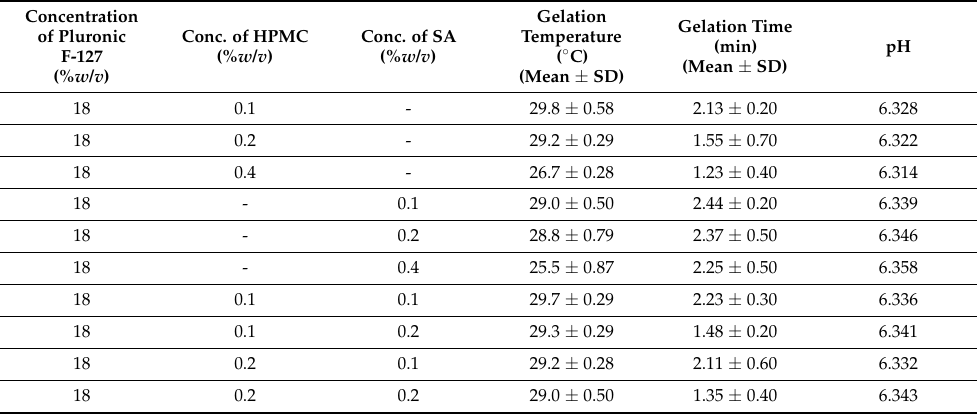
Table 3. Optimization of combinations of bioadhesive polymers and Pluronic F-127. Concentration of